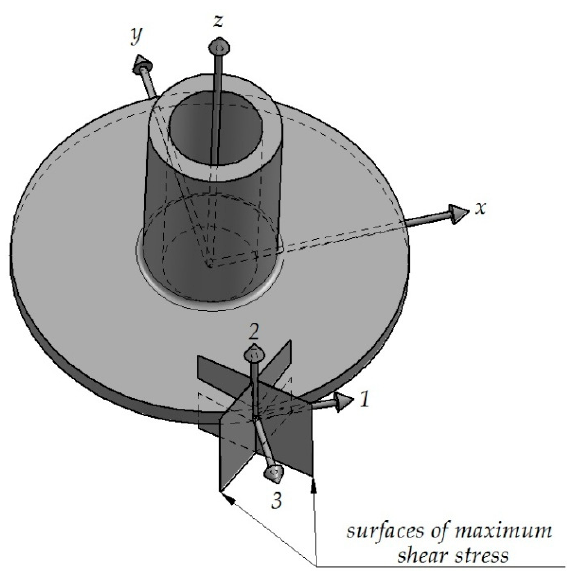
Figure 9. Stress pattern at the point located on the flank of a flange with a diameter at which cracking occurs.